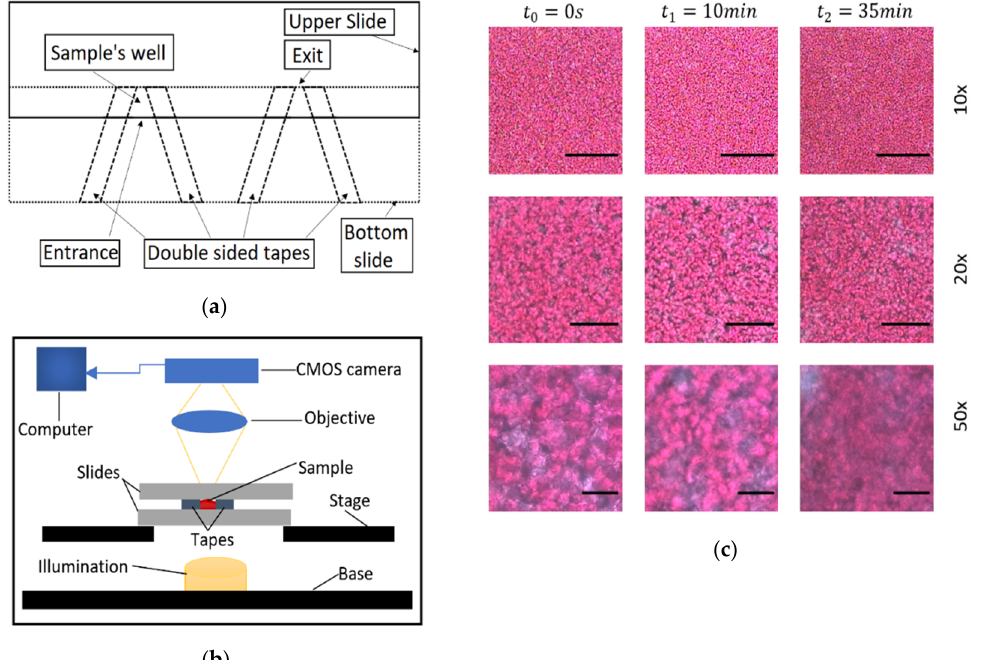
Figure 1. ( a ) The design of the microchannels. ( b ) Schematic of the experimental setup, which is based on forward propagation of light into to the sample, through the objective and into a CMOS camera for the acquisition of data. ( c ) Representative images showing the initial, an intermediate and a final state of coagulated blood at the 10×, 20× and 50× magnification objectives. Scale bars equal to 200, 100 and 40 μ m for the 10× 20× and 50× objectives, respectively.